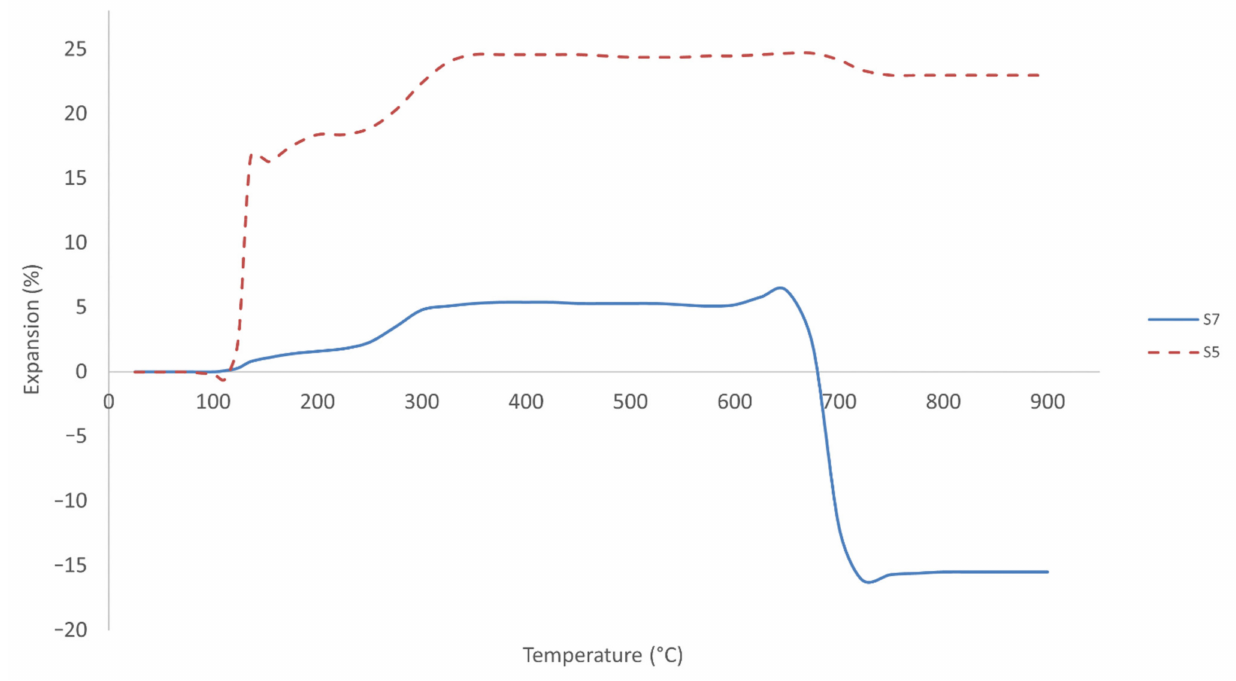
Figure 22. Thermal expansion characteristic of samples S7 and S5 in fire-retardant